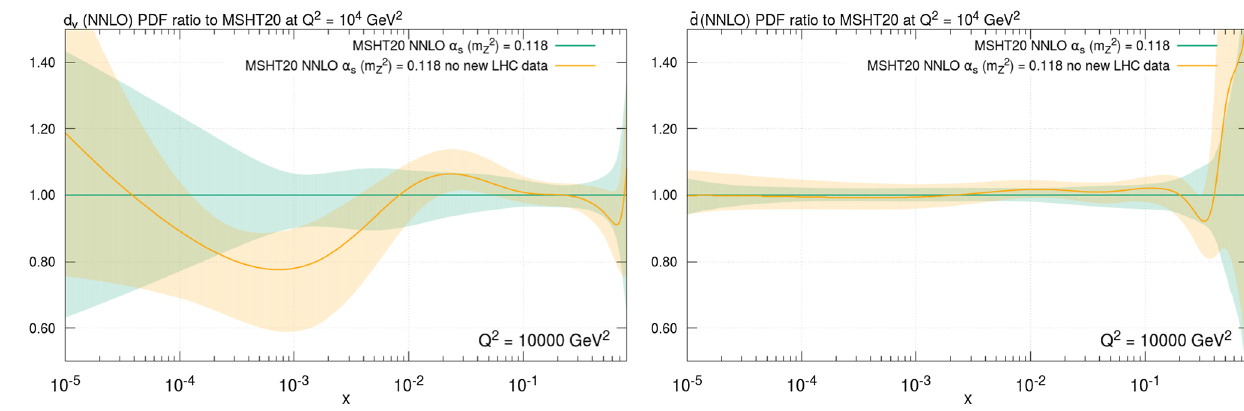
Fig. 48 (Left) Down valence and (right) down antiquark PDF ratios to the MSHT20 default fit showing the effect of the removal of new LHC data at Q 2 = 10 4 GeV 2 at NNLO